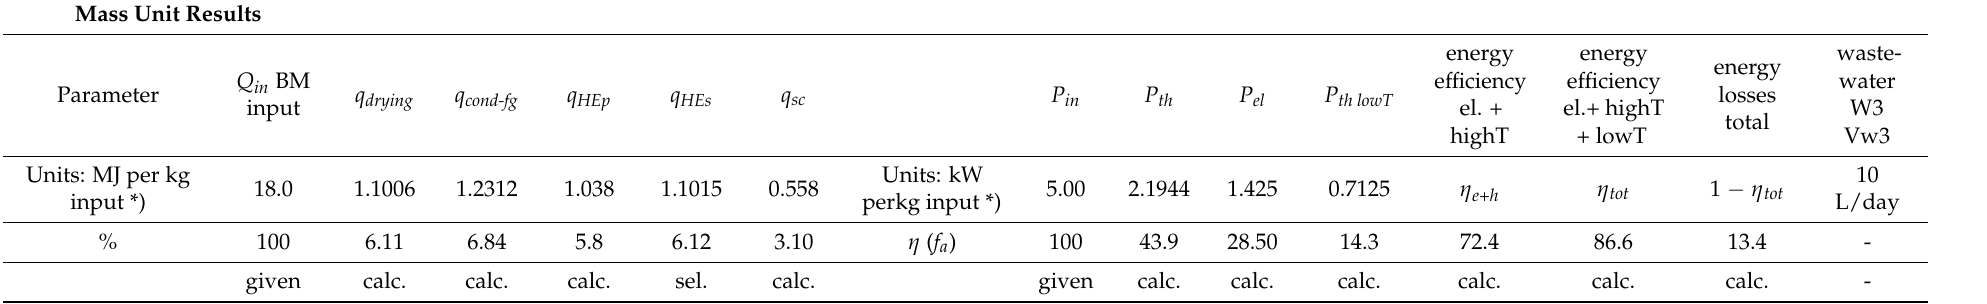
Table 3. Heat balance of unit mass input model calculation and energy outputs with efficiency—accurate